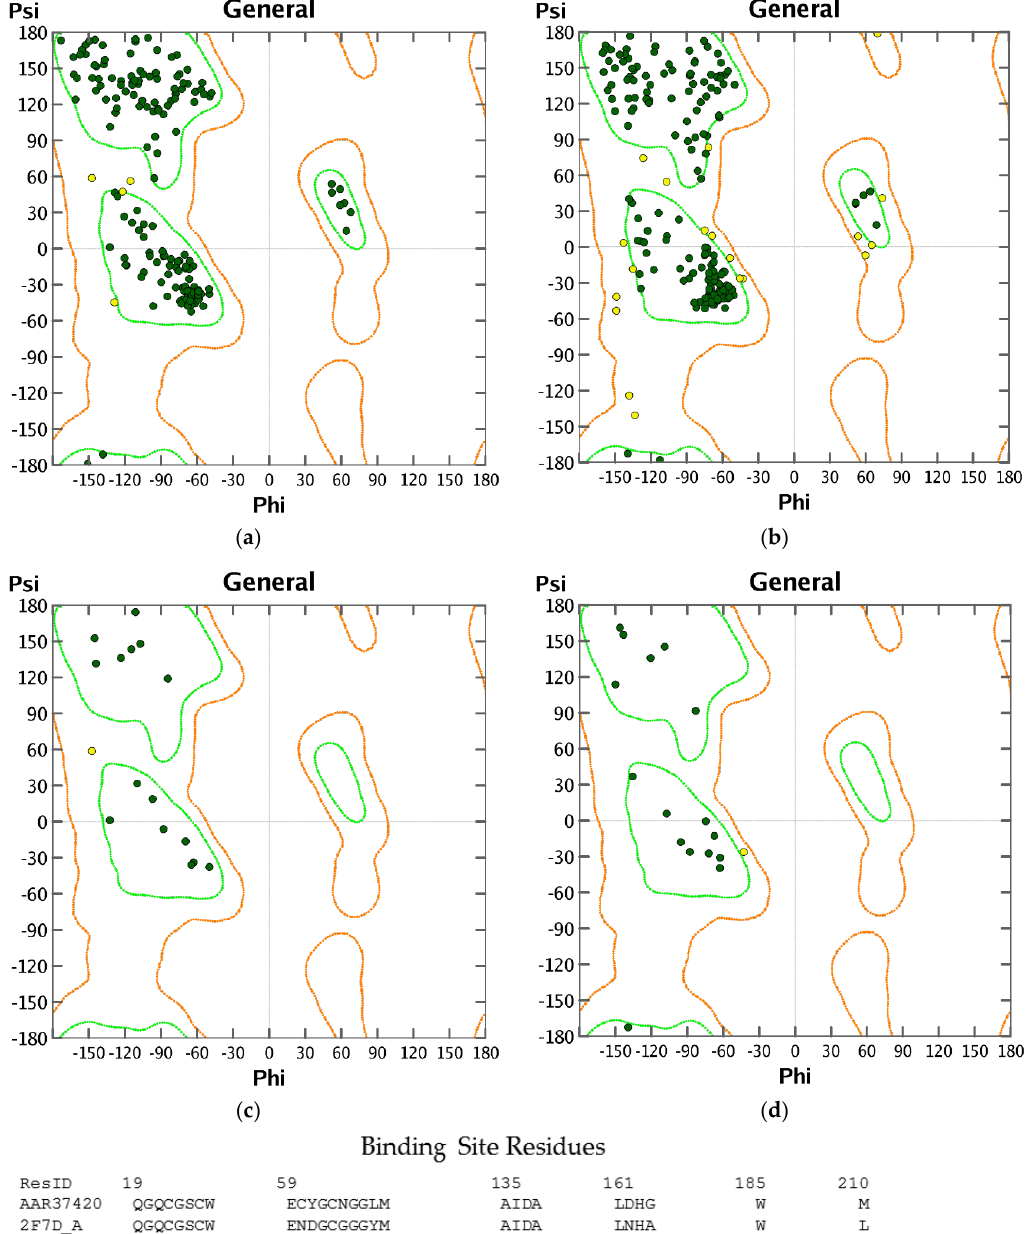
Figure 3. Ramachandran plots of cathepsin K-like protein structures: ( a ) rabbit ( Oryctolagus cuniculus ) cathepsin K (OcCatK, PDB 2F7D [25]); ( b ) homology model of Trichomonas vaginalis papain-like protein, TvCP2; ( c ) binding site of OcCatK; ( d ) binding site of TvCP2.